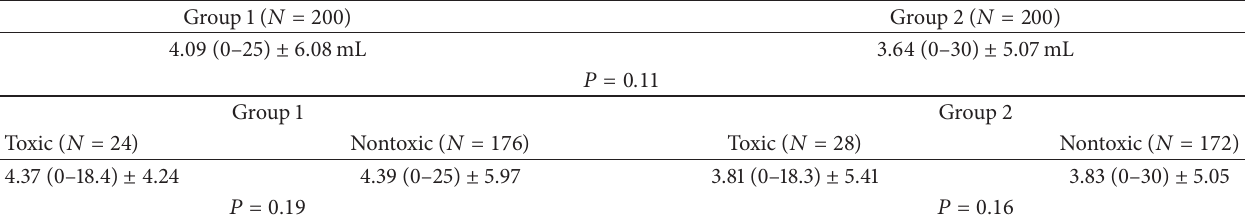
Table 3: Volume of fluid collection in the groups as assessed by USG.